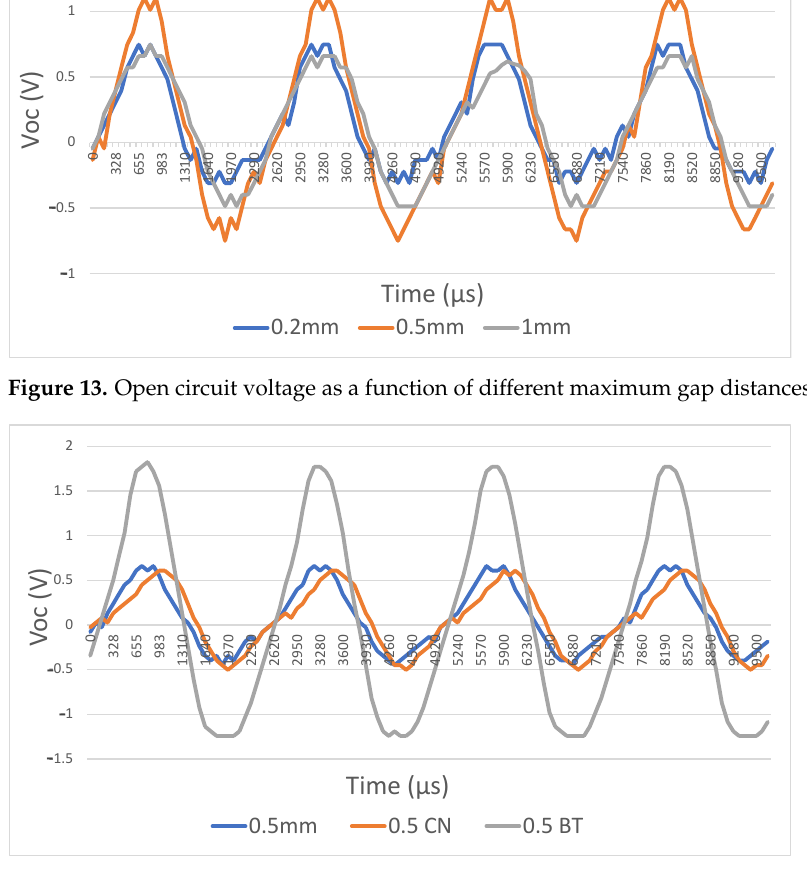
Figure 14. Open circuit voltage for different output power enhancement techniques. For the last test on the harvester structure, we adapted the material of the dielectric layers. Table 8 depicts the results of those tests. We achieved the highest output voltage with paper and teflon as the dielectric layer. We further improved the TENG by adding barium titanate between the electrode and the paper layer. The results are shown in Figure 15.